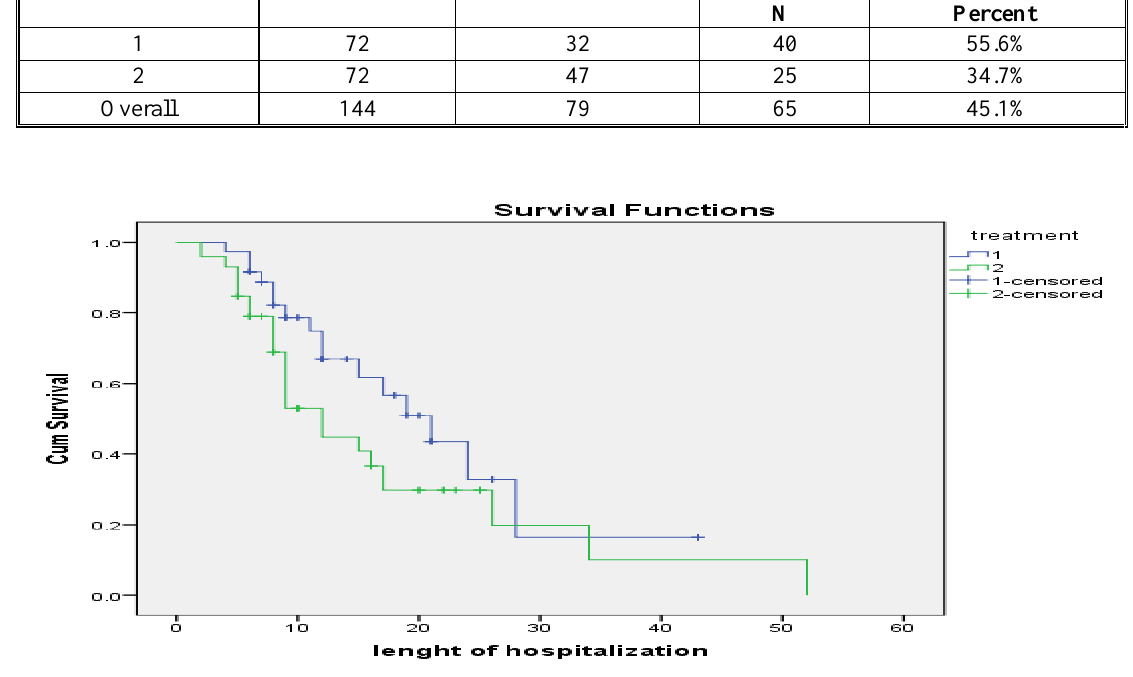
Figure 4. Kaplan Meier survival curve during hospitalization (days) for original Heparin=1, and original Enoxaparin =2, for hospitalized, severe –critical COVID-19 infected patients. Status 1= survival, test = Log Rank (Mantel-Cox).